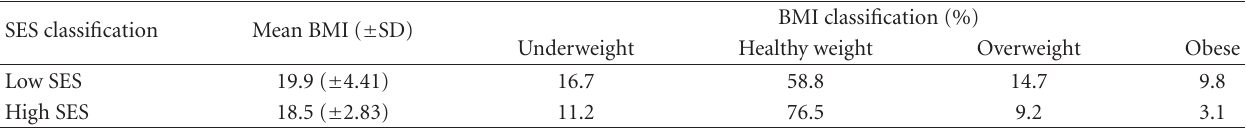
Table 2: Body mass index for each socioeconomic